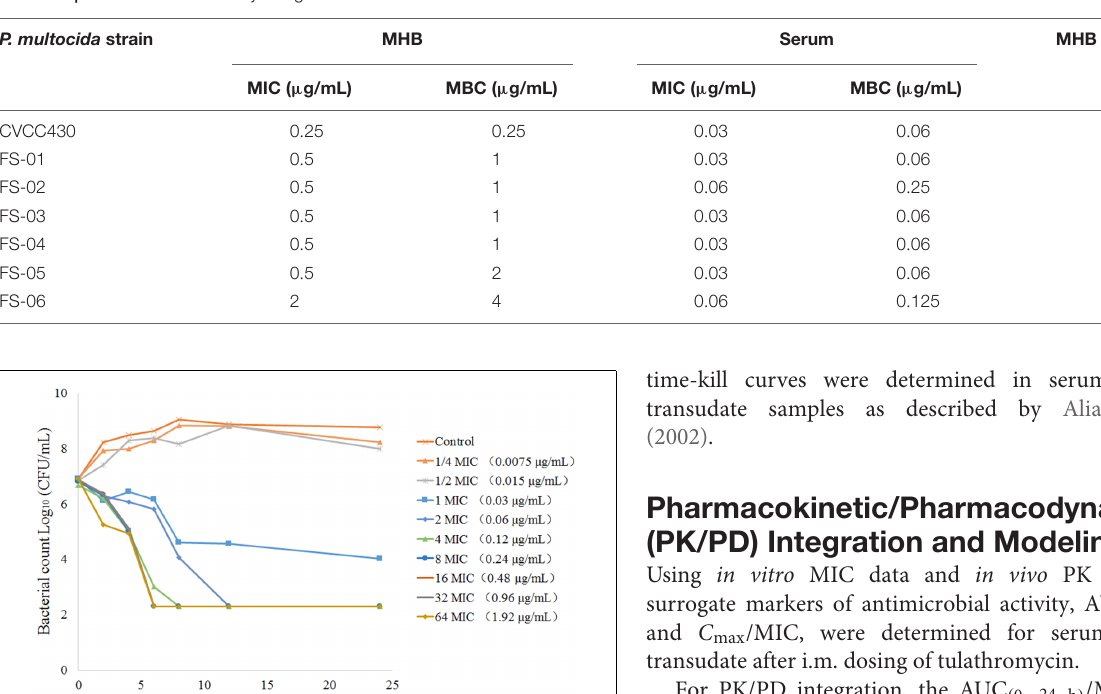
TABLE 4 | The MICs of tulathromycin against P. multocida in MHB and serum.